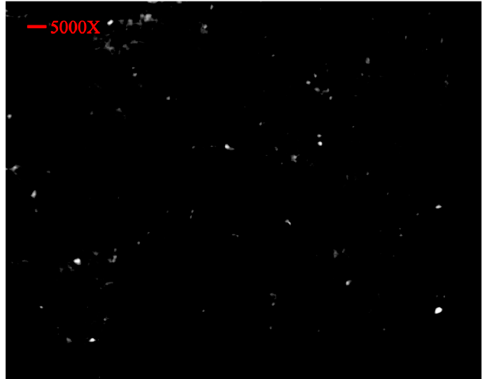
Figure 9. SEM image of PEGylated chitosan nanoparticles at 5000×.